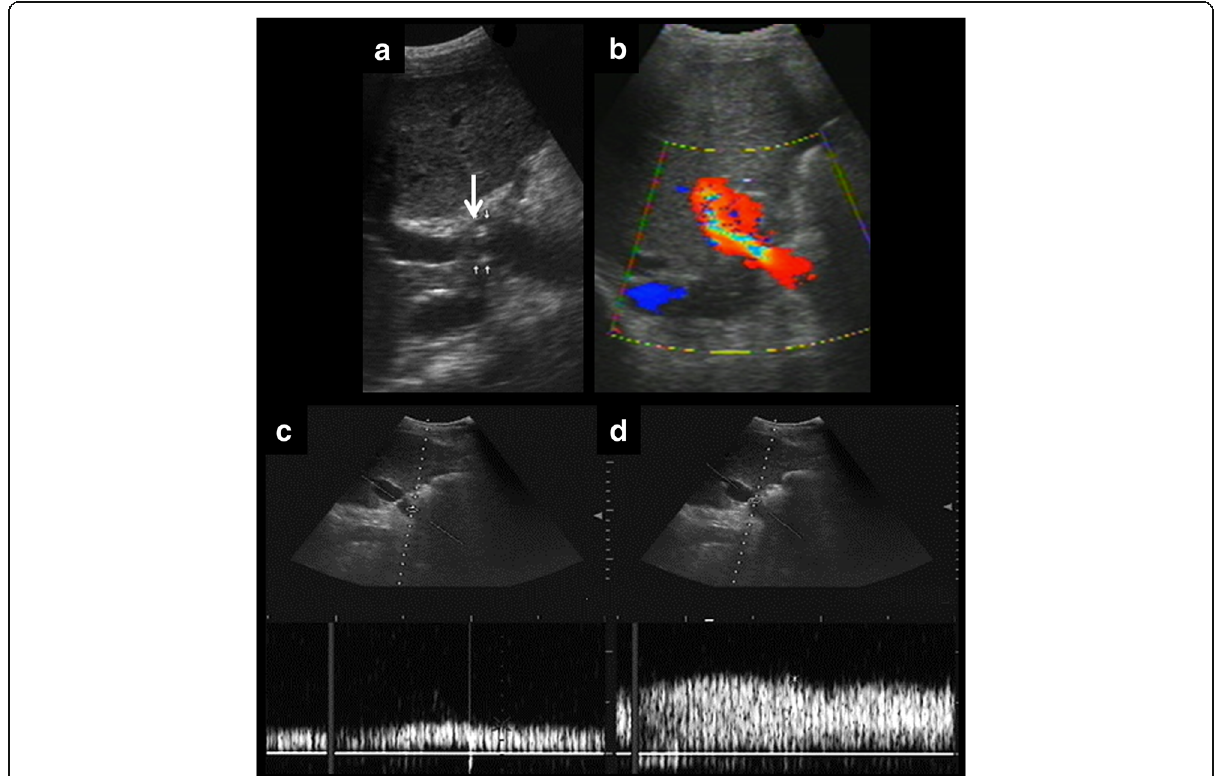
Fig. 10 Usefulness of spectral curves on the assessment of portal vein stenosis. Ultrasound examination shows multiple points of stenosis ( a ). Colour Doppler demonstrates turbulent flow ( b ). Spectral curves show a characteristic pattern before and at the stenosis. In the prestenotic segment ( c ), we can appreciate a low flow. In the stenotic segment ( d ), high-speed flow is seen (peak velocity over 125 cm/s). Stenotic/ prestenotic ratio is a useful measurement. In this case, the result is clearly more than